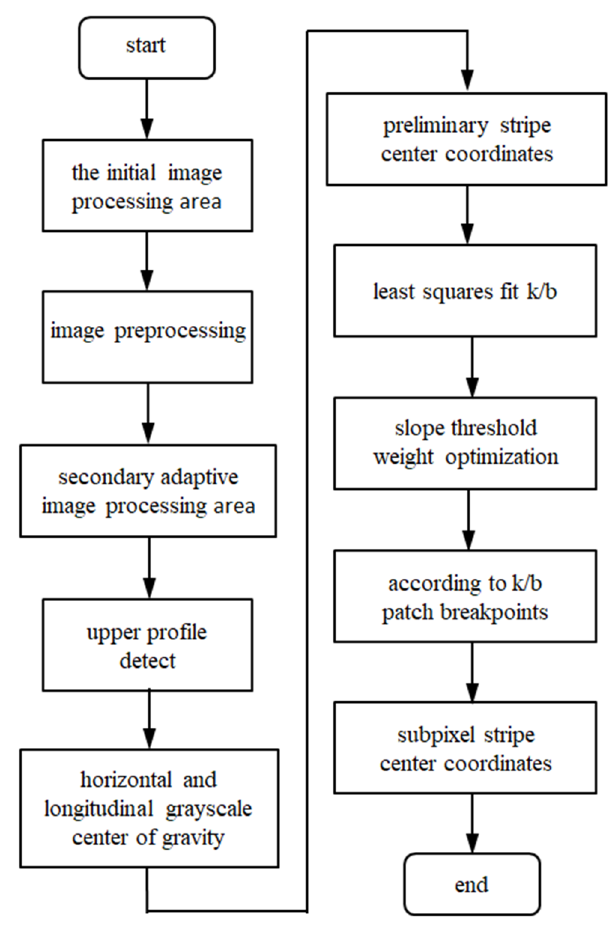
Figure 1. Algorithm flow chart.